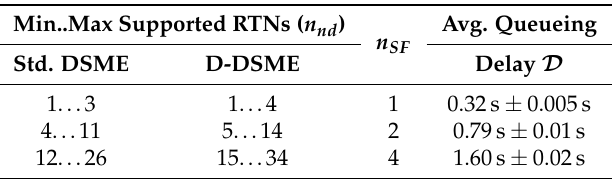
Table 3. Simulation